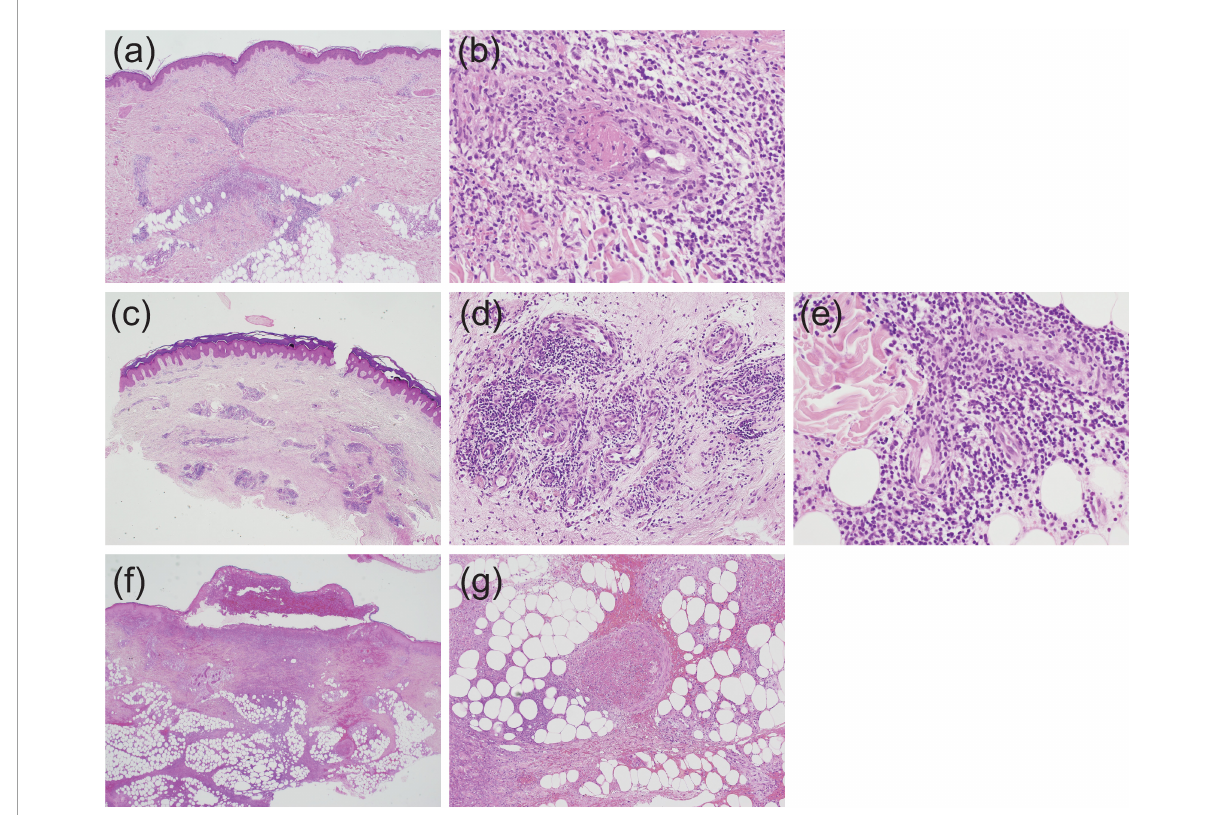
FIGURE3 Histopathological findings indicative of vasculitis in Behçet’s disease (BD) skin lesions; all slides were stained by hematoxylin and eosin, and the magnification is shown in parenthesis. (a,b) Case 1, perivascular neutrophilic infiltration in the dermis ( a , × 20) and subsequent occlusion of the involved blood vessel ( b , × 400). (c–e) Case 2, perivascular dense infiltration in the dermis ( c , × 20), and prominent accumulation of neutrophils and lymphocytes around blood vessels in the mid ( d , × 200) and deep ( e , × 400) dermis. (f,g) Case 3, extensive dermal infiltration of